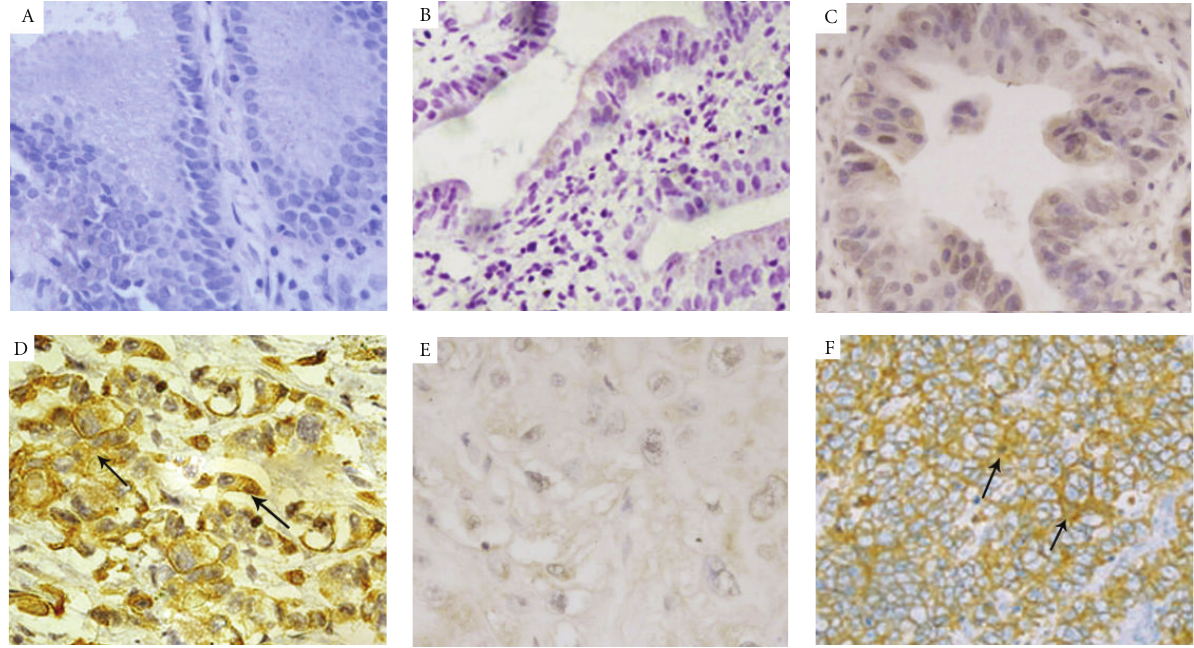
Figure 1: Immunohistochemical stainings for CD97 and CD55 in GBC tissues (original magnification × 200). (A) and (B) CD97 and CD55 stainings were negative in nontumor brain tissues; (C) weak CD97 positive expression was found in the cytoplasm at various levels in GBC tissues with low clinical stage; (D) strong CD97 positive expression was found in the cytoplasm at various levels in GBC tissues with high clinical stage; (E) weak CD55 positive expression was found in the cell membrane at various levels in GBC tissues with low clinical stage; (F) strong CD55 positive expression was found in the cell membrane at various levels in GBC tissues with high clinical